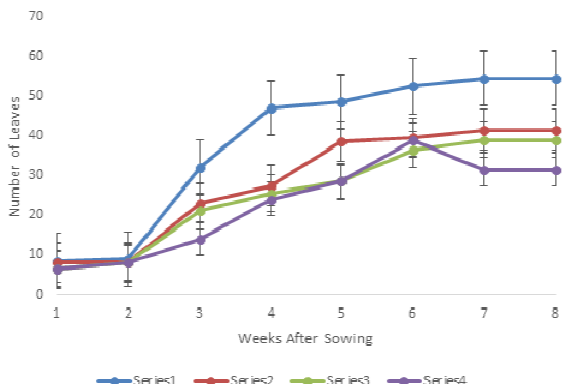
Fig. 2. The effect of Magnesium application on the number of leaves of C. olitorius grown under different levels of nutrient solution